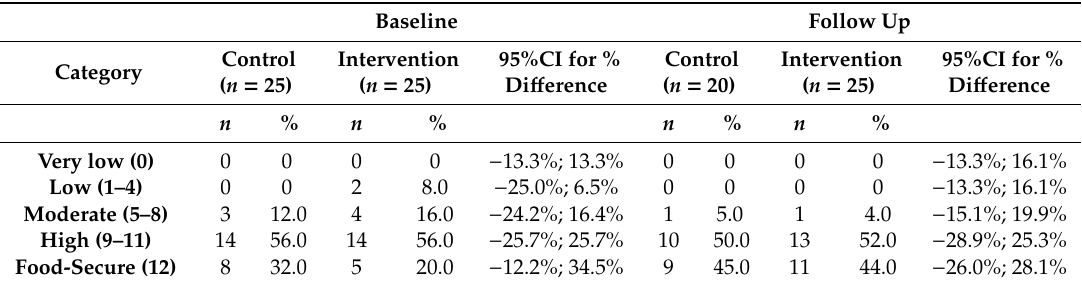
Table 4. Months of Adequate Household Food Provisioning (MAHFP) score categories of control and intervention groups at baseline and